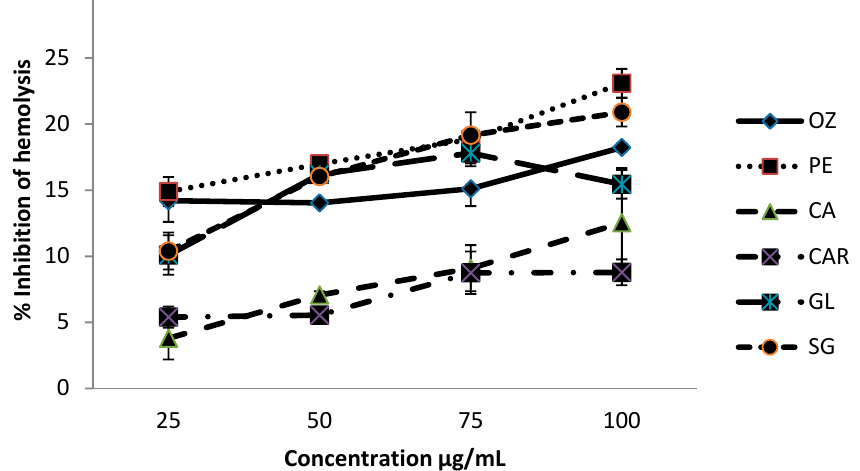
Figure 1. Effect of six green leafy vegetables on inhibition of hemolysis. Values represent means of triplicate readings. CAR— C. auriculata ; GL— G. lactiferum ; OZ— O. zeylanica ; PE— P. edulis ; CA— C. asiatica ; SG— S. grandiflora . Data are presented as the means ± standard deviations of three replicate determinations.